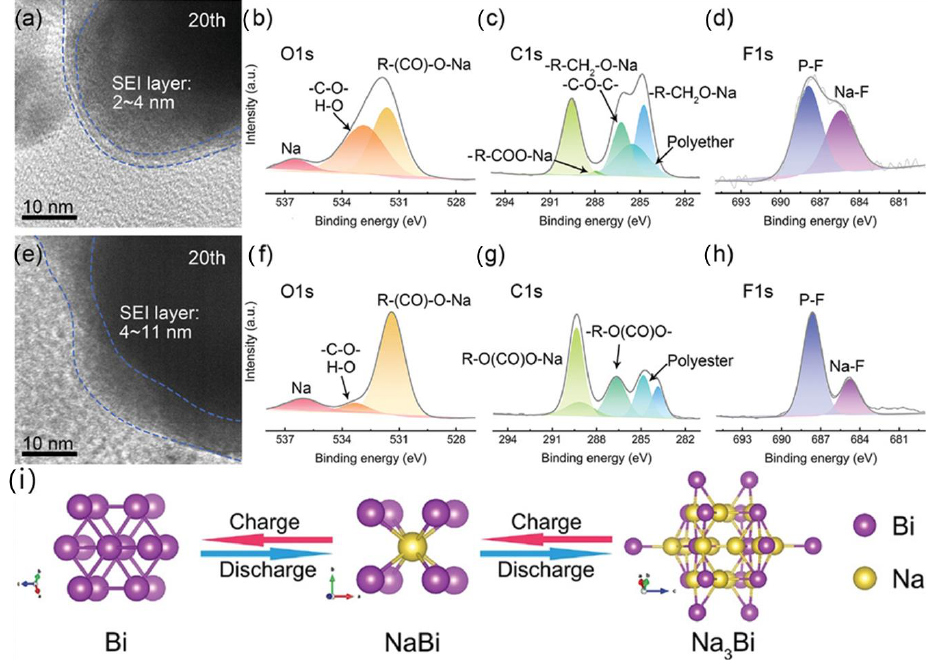
Figure 7. ( a ) HRTEM images of the Bi@C ⊂ CFs after 20 cycles in DME-based ( a ) and EC/DEC-based ( e ) electrolytes. ( b – d , f – h ) The high-resolution XPS spectra of C, O, and F for Bi@C ⊂ CFs with EC/DEC-based and DME-based electrolytes after cycles. ( i ) Reaction mechanism of Bi in charge and discharge process [103] (copyright Wiley